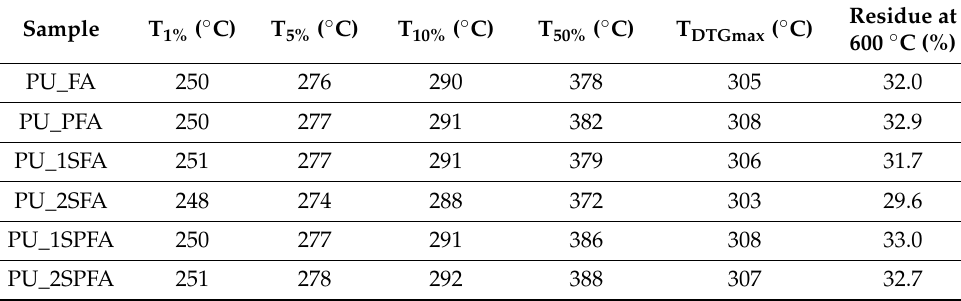
Table 4. Characteristics of thermal degradation of the PU